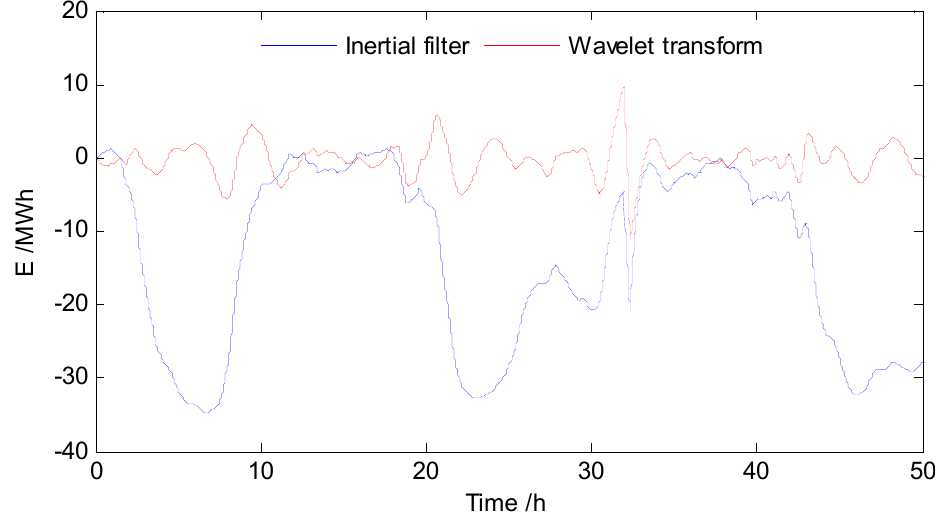
Figure 17. The comparison of energy storage capacity in a wind farm over 50 h based on Inertial Filtering and Wavelet Transform,